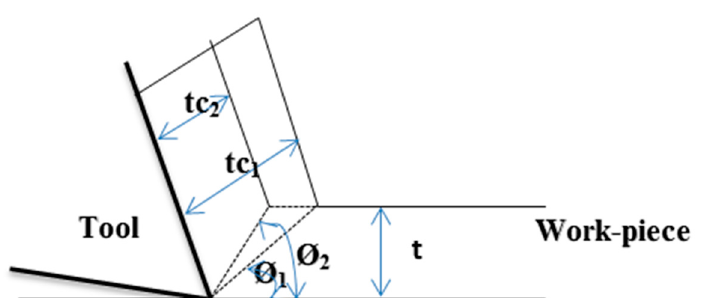
Figure 5. E ff ect of small (Ø 1 ) and large (Ø 2 ) shear angle on chip thickness ( t c ) and length of shear Figure 5. Effect of small ( Ø (cid:2869) ) and large ( Ø (cid:2870) ) shear angle on chip thickness ( 𝑡 (cid:3030) ) and length of shear plane for a given tool and un-deformed chip thickness ( t ) plane for a given tool and un-deformed chip thickness ( 𝑡 ) [26].